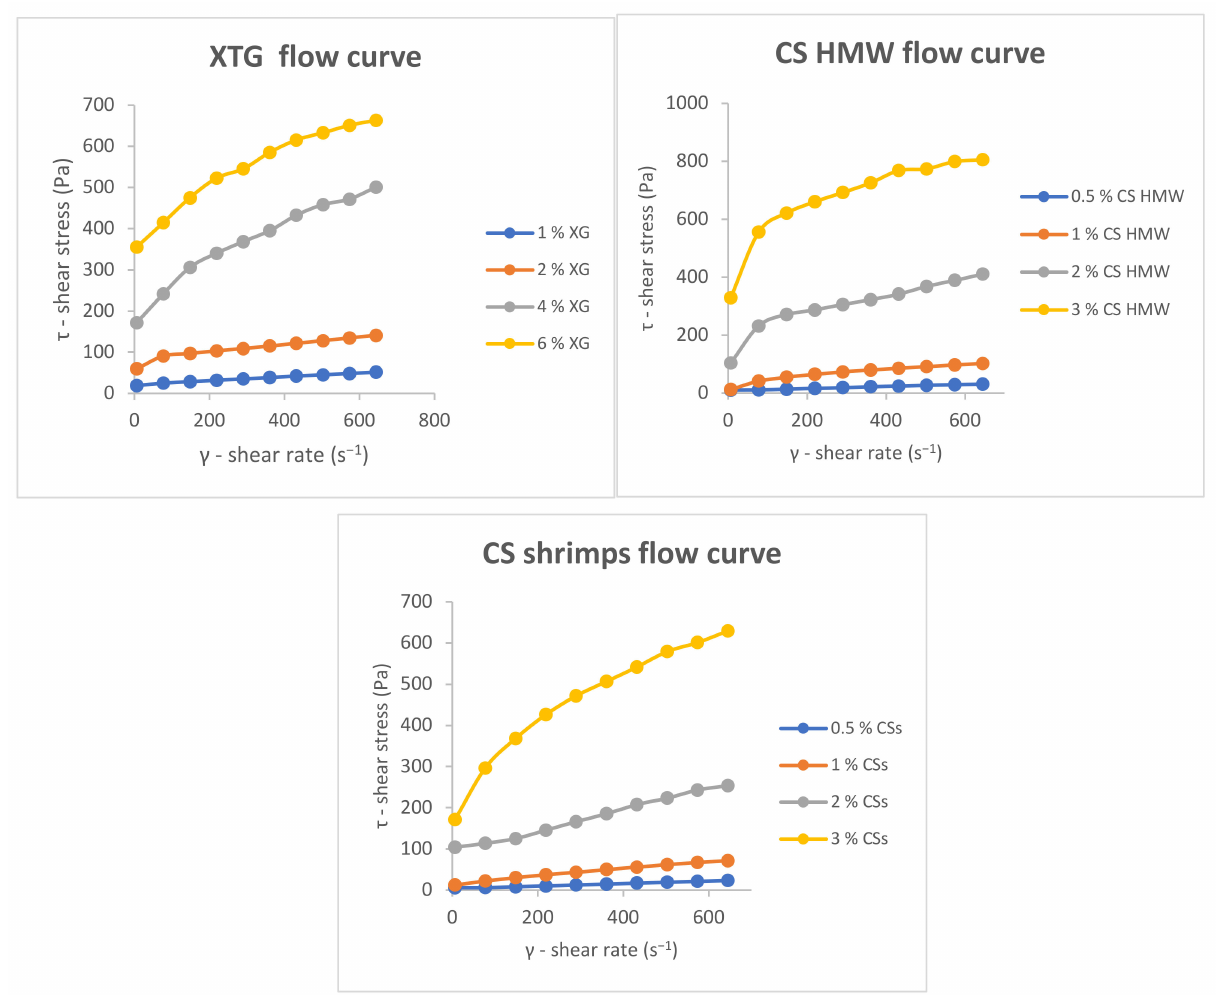
Figure A1. Flow curves of polysaccharide-based hydrogels of different concentrations at increasing shear